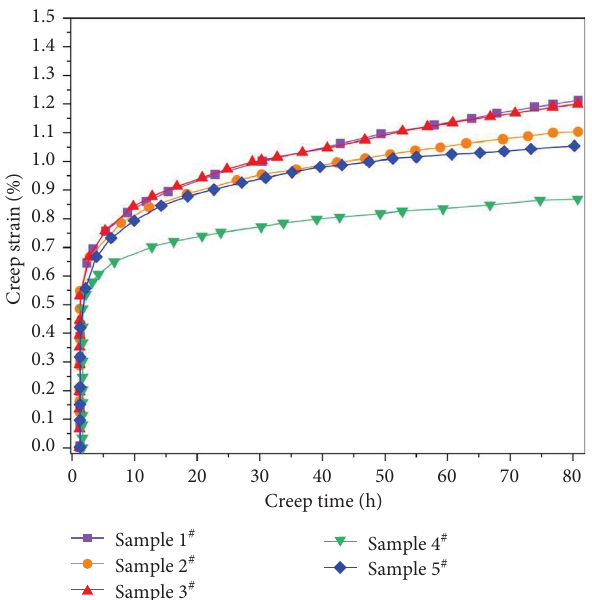
Figure 5: Creep curve of Ti-6Al-4V alloy at diferent forging